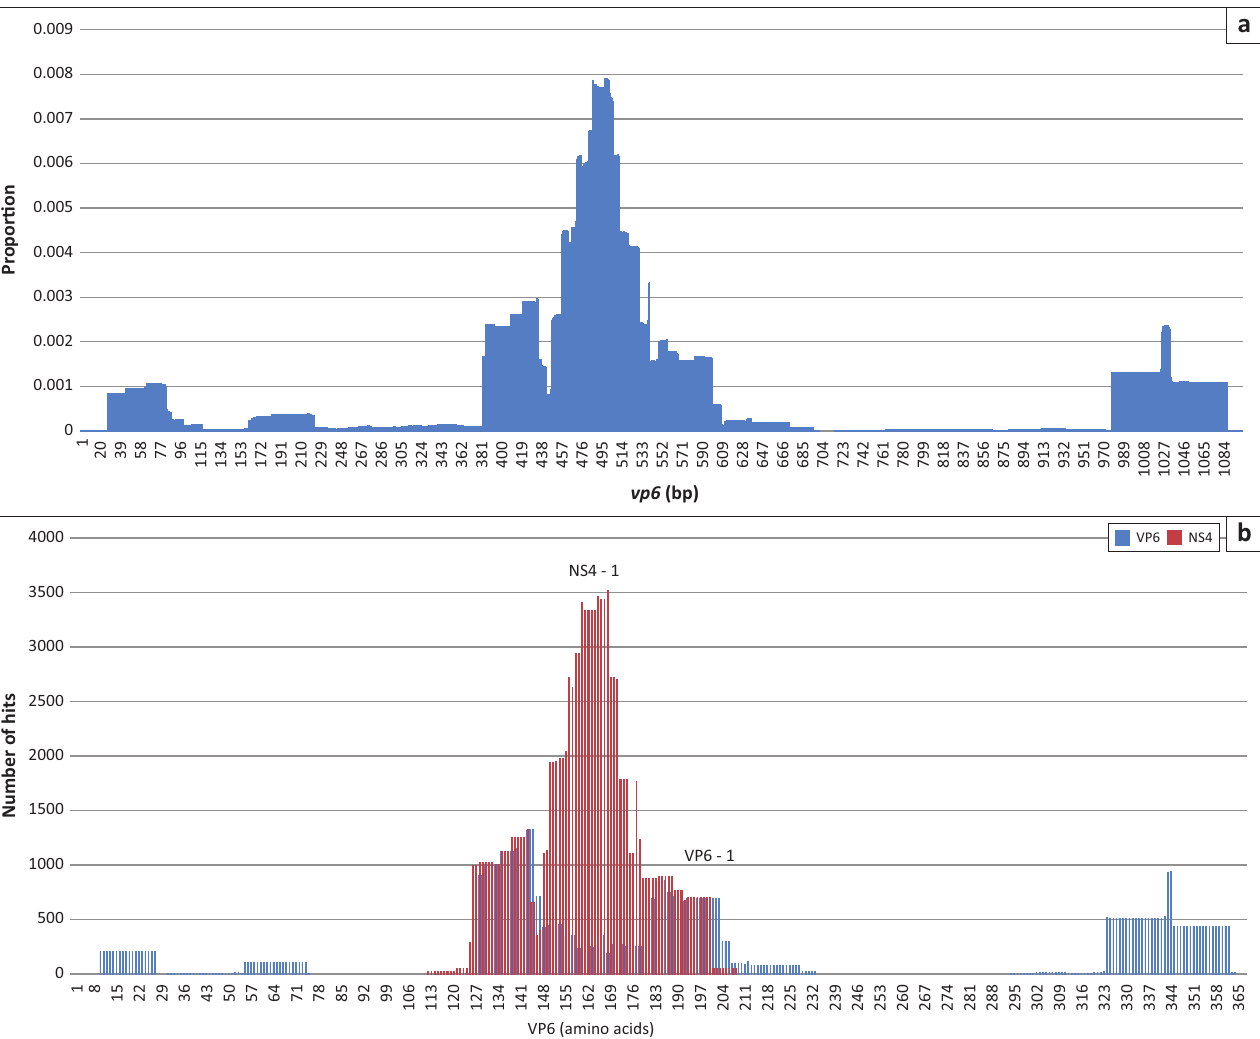
Antigenic regions NS4-1 and VP6-1 are indicated. FIGURE 7: A comparison of the pattern of nucleic acid sequences mapping to the gene and the deduced amino acid alignments of day 28 VP6 data of Horse 2. The translated sequences are matched to either the VP6 or the NS4 amino acid sequence. NS4 is in the +2 reading frame from bp 197 to 631 but positioned with VP6 for ease of comparison. (a) Nucleic acid mapping and (b) amino acid